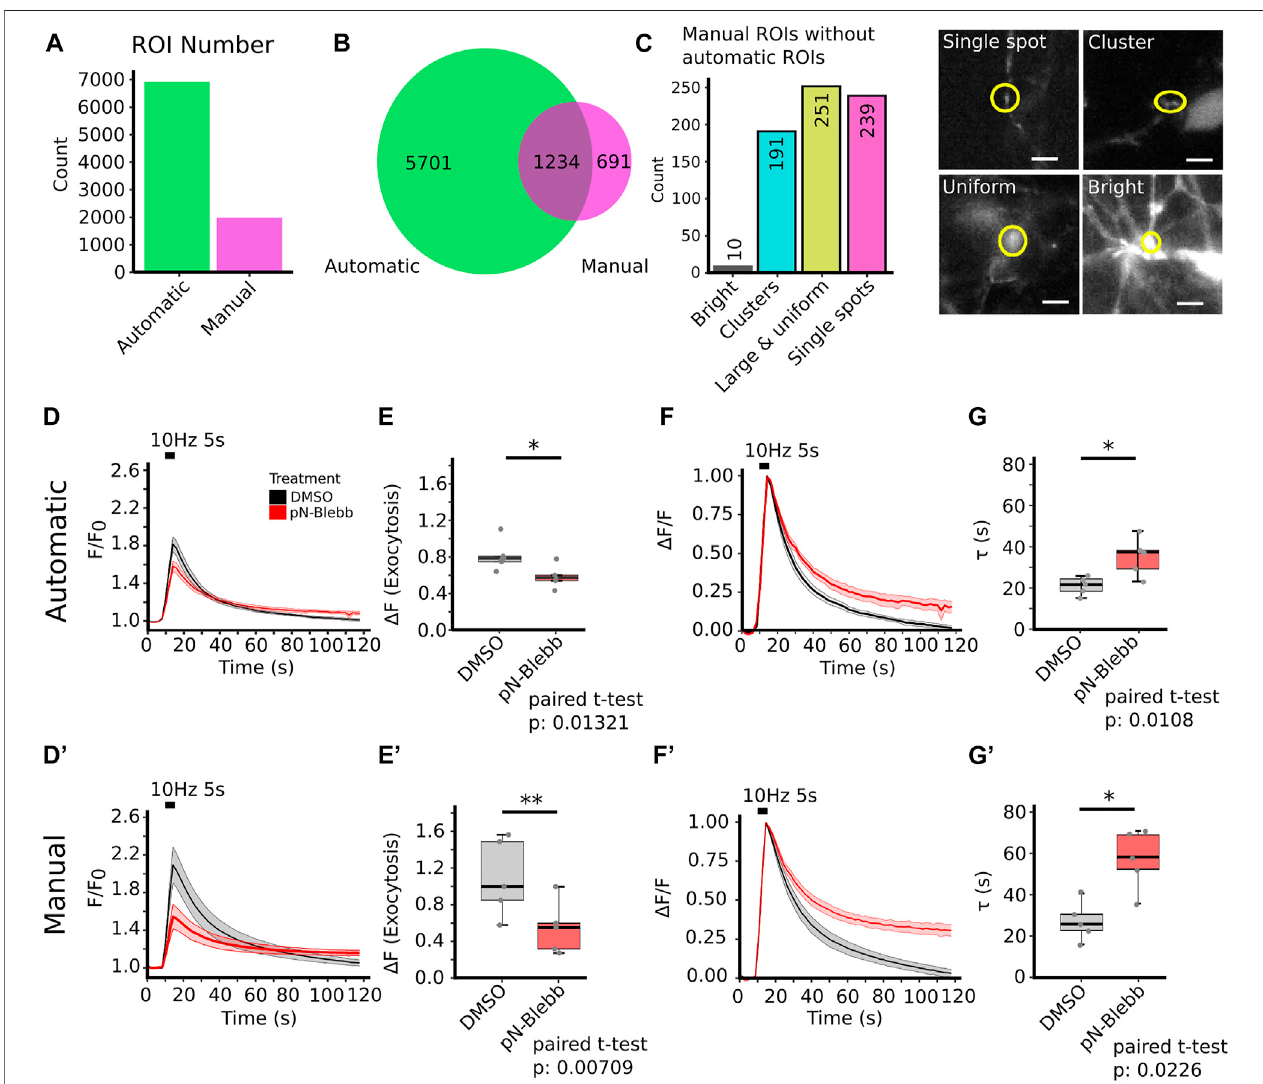
FIGURE4| SynActJ allowstherapid analysisofsynaptic activityusingsynapto-pHluorin imagingand reproducestheresults ofacomparablemanualanalysis. (A) The automatic image segmentation allows extracting many more ROIs from the image data compared to a manual segmentation. (B) 64% of the manual ROIs have been detected in the automated analysis. (C) Many of the manual ROIs without automatic ROIs are clusters of boutons or relatively large, potential out of focus objects, aside from single boutons (false negative automatic segmentation), example images of these cases are provided. [ (D,E) compare to (D 9 ,E 9 ) ] The automaticimageanalysisisabletoreproducetheresultsfromamanuallyperformedimageanalysis(Soykanetal.,2017)showingsigni fi cantdecreaseinpeaksignal increase after stimulation. (F,G) compared to (F 9 ,G 9 ) A signi fi cant delay ofSV endocytosis and reacidi fi cation can be detected in the automatic and manual analysis. Dataarepresented asmean ± standarderror ofthemean (SEM)in allpanels; n.s notsigni fi cant;* p < 0.05; ** p < 0.01.N (cid:1) 5independentexperiments;paired t -test. Scale bar corresponds to 5 µm (C) .